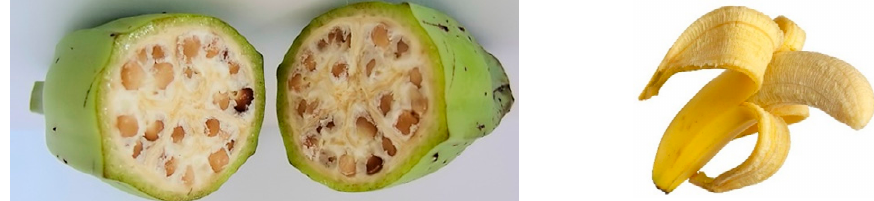
Figure 5. Wild banana is diploid and produces seeds ( left ), whereas cultivated banana is sterile and seedless because it is a triploid ( right ).